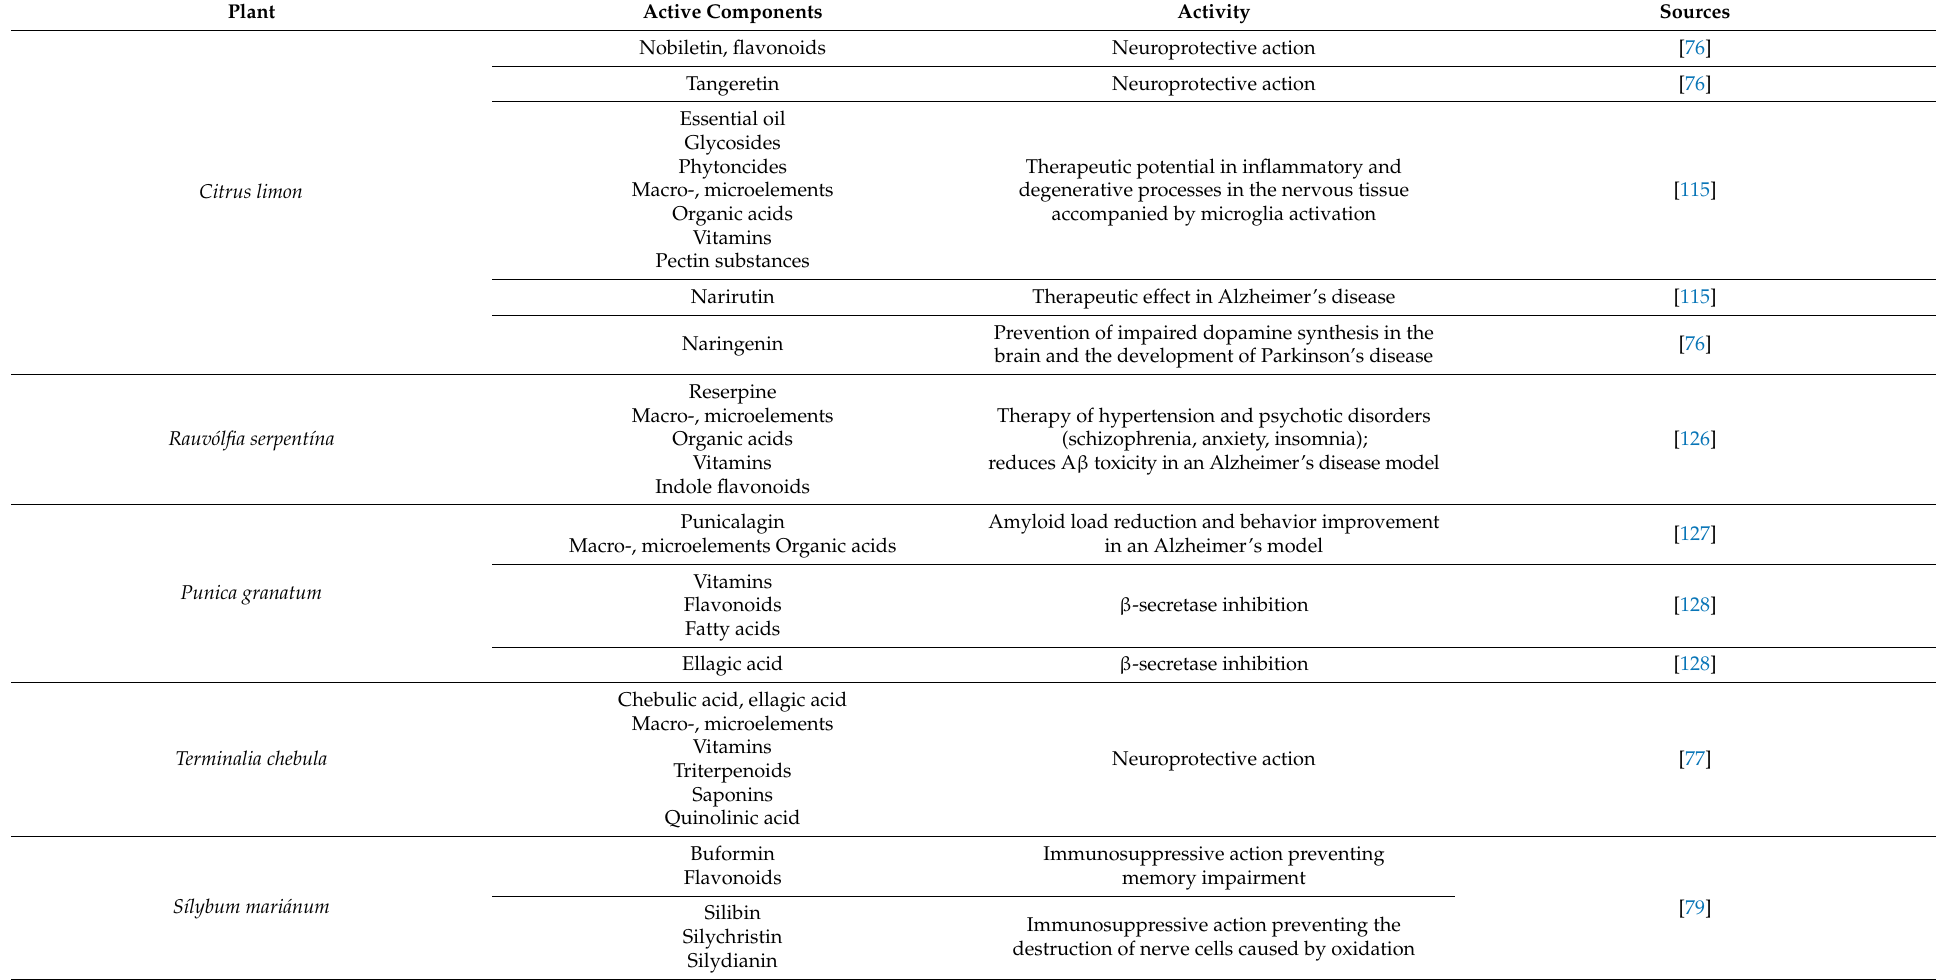
Table 1. Anti-neurodegenerative action of various plant